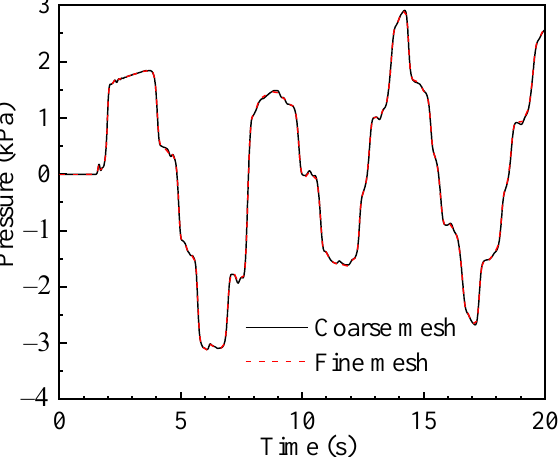
Figure 7. Aerodynamic pressure time histories obtained by coarse mesh and fine mesh.